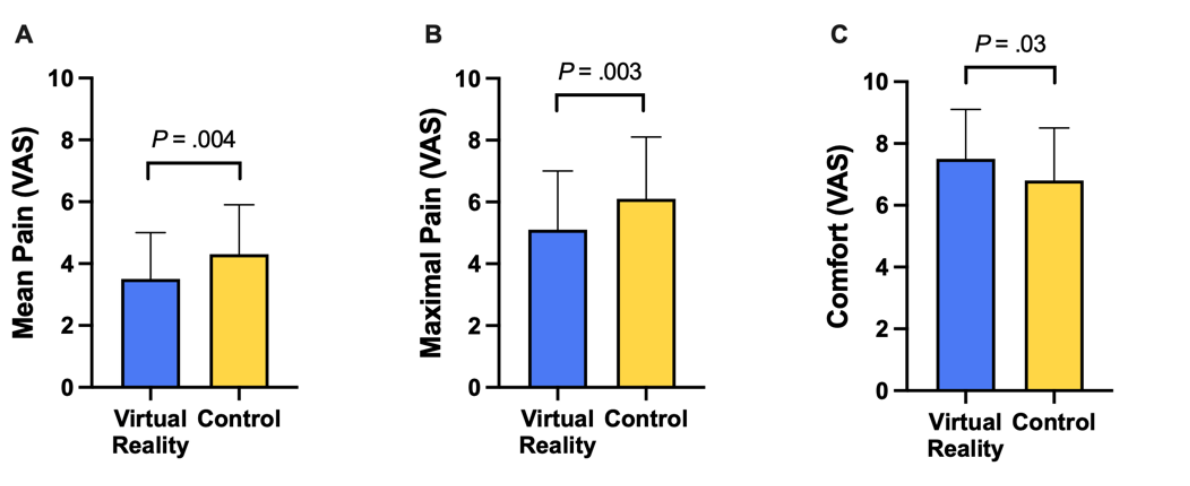
Figure 2. Mean pain, maximal pain, and comfort assessment in the virtual reality and control